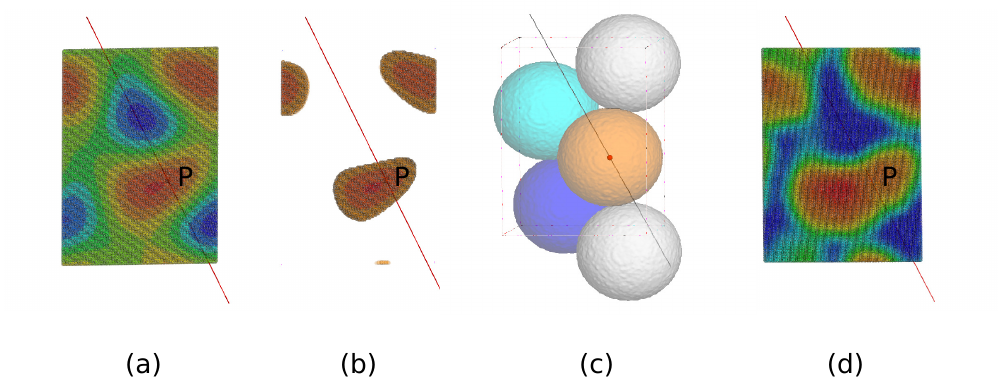
Figure 1. ( a ) A section of the weighted average density map w 1 with σ 1 = 15 Å. The red color represents high-density regions and the blue color indicates low-density regions. ( b ) From w 1 , weighted average densities in the top 20% are recorded. ( c ) For any point P on the non-crystallographic symmetry (NCS) axis, a sphere is drawn with a radius so that the sphere barely touches its crystallographic-symmetry copies indicated by different colors. ( d ) After updating the centroid, another weighted average density map w 2 is computed with σ 2 = 5 Å. A mask for NCS averaging can be constructed from w 2